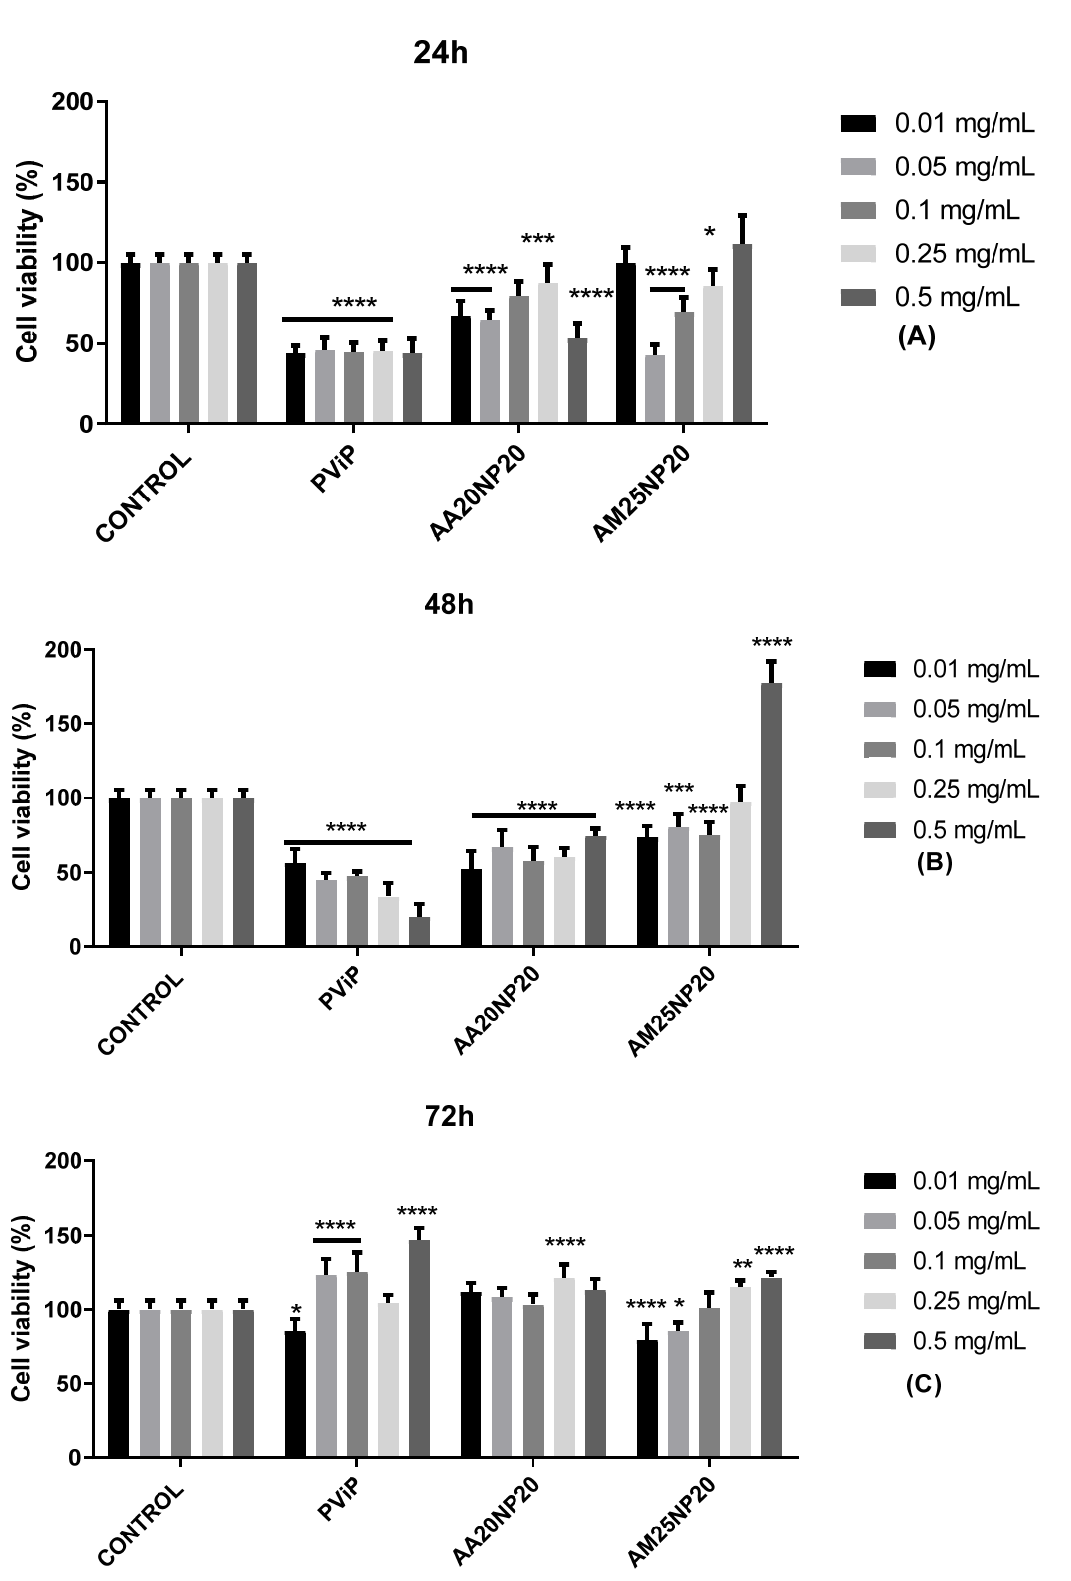
Figure 7. Evaluation of the cytotoxic activity of the polymer samples on fibroblast cells after ( A ) 24, ( B ) 48, and ( C ) 72 h exposure in the particle concentrations of 0.01, 0.05, 0.1, 0.25, and 0.5 mg/mL. Asterisks are related to different confidence intervals associated with statistical significance: * 95% with p ≤ 0.05, ** 99% with p ≤ 0.01, *** 99.9% with p ≤ 0.001, and **** 99.99% with p ≤ 0.0001.